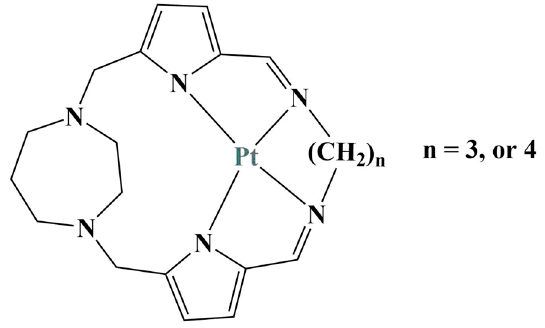
Figure 9. The macrocyclic Pt(II) complexes described in [36].